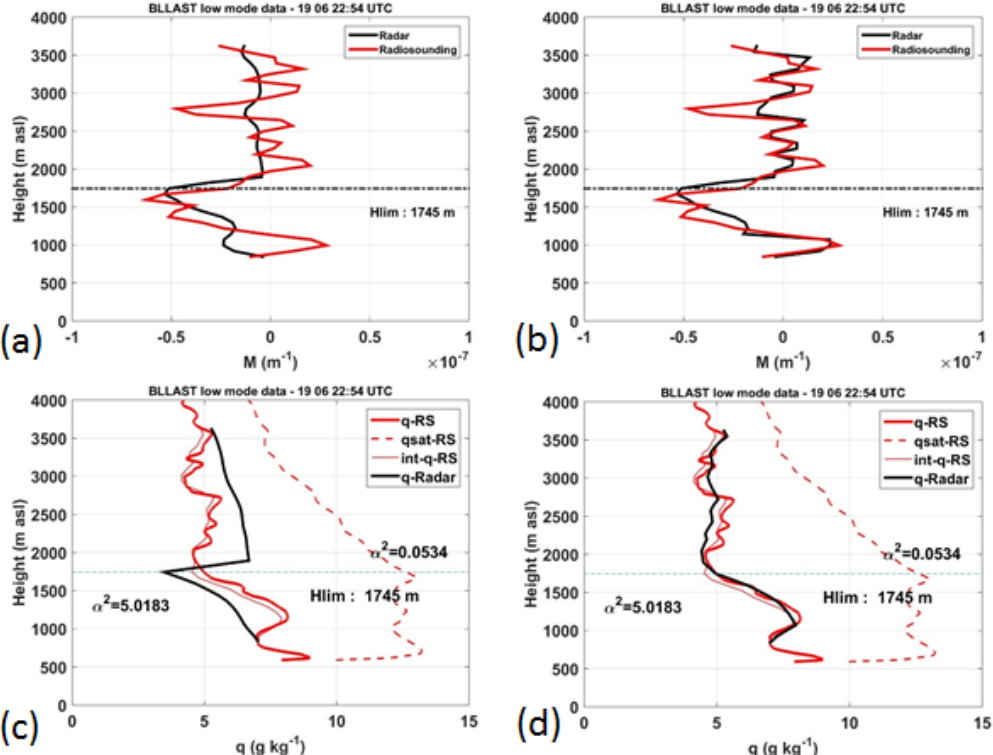
Figure 1. Vertical profiles of refractivity gradient (a, b) and humidity (c, d) using a systematic negative sign for M (a, c) or after assigning to M the sign of M provided by the RS observations (b, d) . RS values (q-RS) are red solid lines and radar values (q-Radar) are black solid lines. The thin red lines (int-q-RS) identify the humidity profiles retrieved from the integration of M RS after averaging the RS observations by slices of 75m, to match the vertical resolution of the radar. The red dashed line (qsat-RS) is for the saturated humidity profile. The horizontal dashed line delineates Hlim, the transition level used to separate the upper and lower part of the profile. The two values of α 2 (calibration coefficients), over or below Hlim, are also